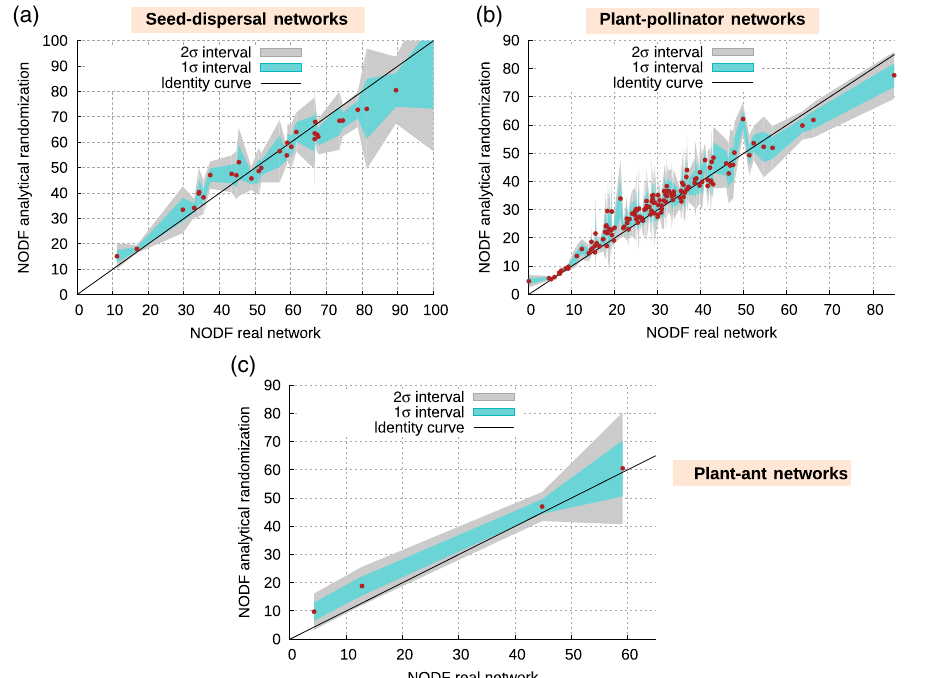
FIG. 6. Significance of the nestedness of real networks. The figure shows the empirical measure of nestedness against the average value of nestedness in the generated statistical ensemble (red dots) for the 167 real mutualistic networks. The three panels correspond to different kinds of mutualistic systems: (a) seed-dispersal, (b) plant-pollinator, and (c) plant-ant. In particular, the ant-plant mutualism is where ants provide plants with services like defense from herbivores, pollination, and/or gathering of nutrients, while plants offer shelter and/or food. The shadowed areas represent 1 (teal) and 2 (light gray) standard deviations of the mean. Further details about the number of networks whose nestedness are within these boundaries are provided in Table I. A detailed significant test results in only three networks having a statistical significant (in all cases under-represented) nestedness value. Overall, the results indicate that the nestedness of these mutualistic networks is not